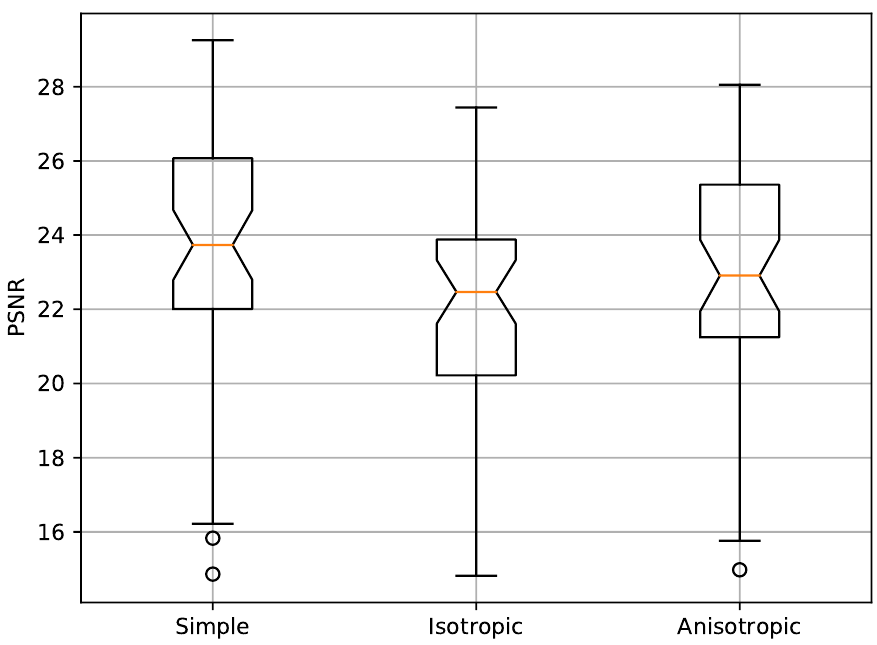
Figure 6. PSNR (dB) of the daltonised versus the original images for the simple, isotropic, and anisotropic daltonisation